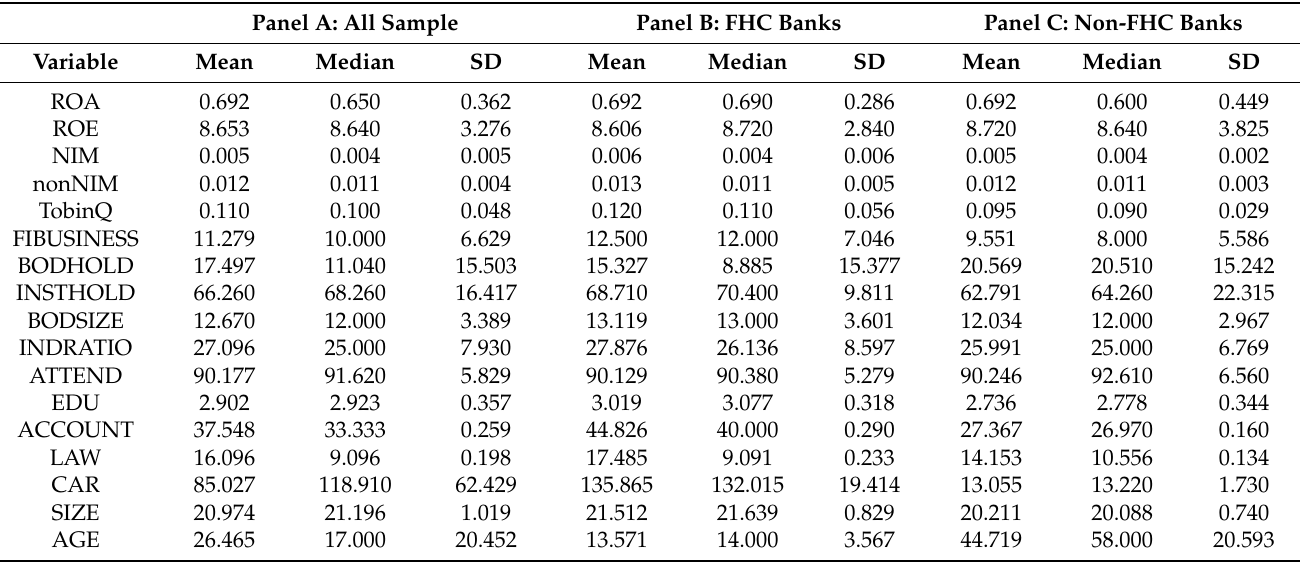
Table 2. Descriptive statistics of variables.